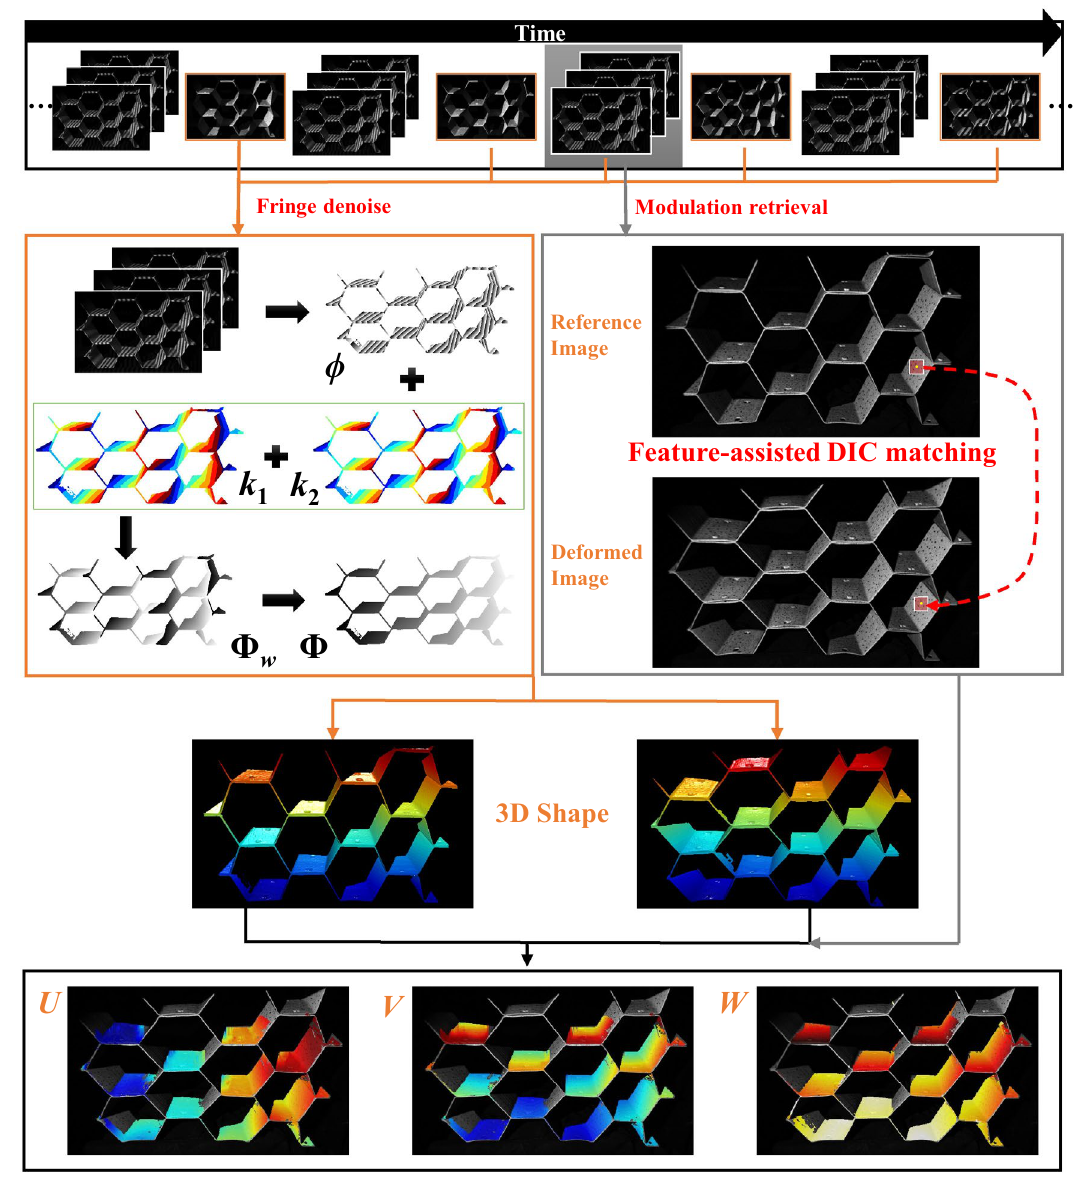
Figure 4. Framework of the proposed 3D shape and deformation measurement